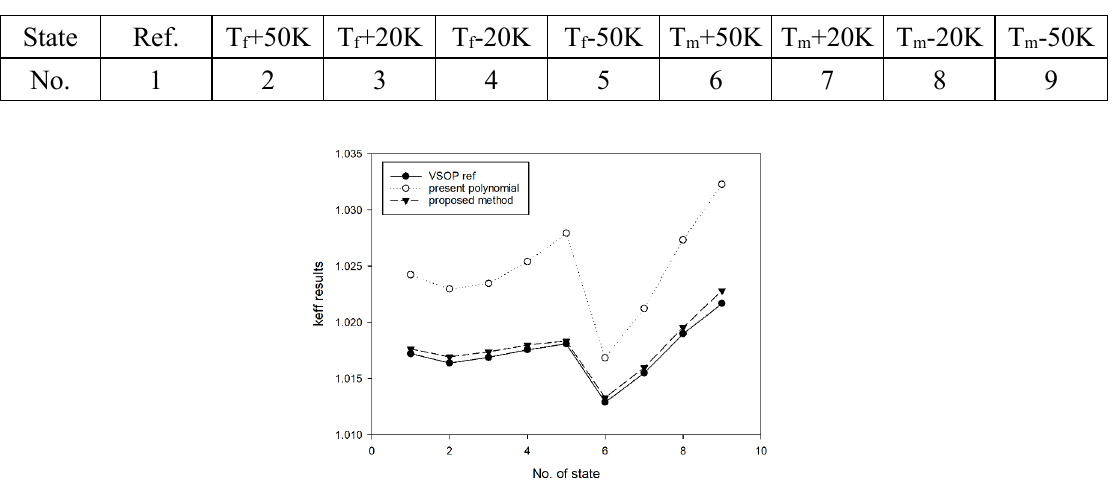
Figure 5. Comparison of k